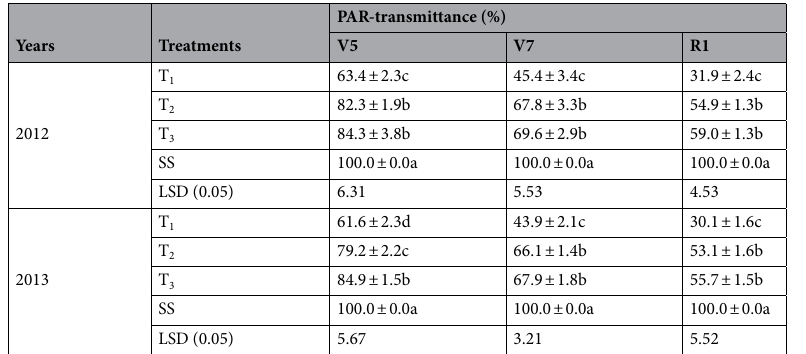
Table 1. Effect of different strip-width treatments on photosynthetically active radiation transmittance (PAR-transmittance) of soybean canopy at the fifth trifoliate stage (V5), seventh trifoliate stage (V7), and flower initiation stage (R1) in cropping seasons from 2012 to 2013. Treatment codes represent narrow-strips (T 1 , 180 cm); medium-strips (T 2 , 200 cm); and wide-strips (T 3 , 220 cm) in maize/soybean relay intercropping system. SS is the sole cropping system of soybean. Means are averages over three replicates ± standard error of the mean. Means that do not share the same letters in a column differ significantly at p ≤ 0.05 using least significant differences, calculated separately for each year.